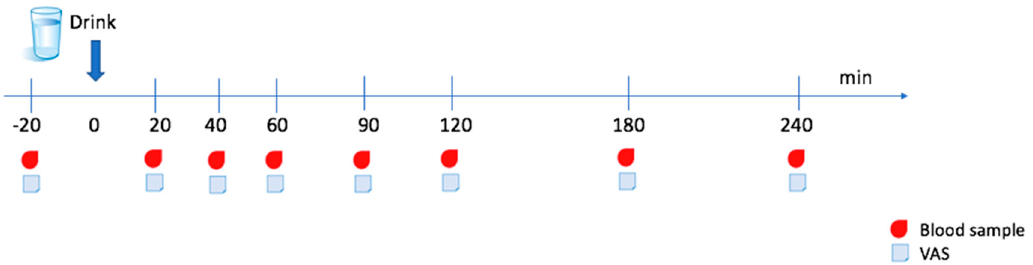
Figure 1. Experimental protocol and fixed time points for blood sample collection and visual analogue scale (VAS) questionnaire. Time of drink consumption was designated as time zero (0 min).